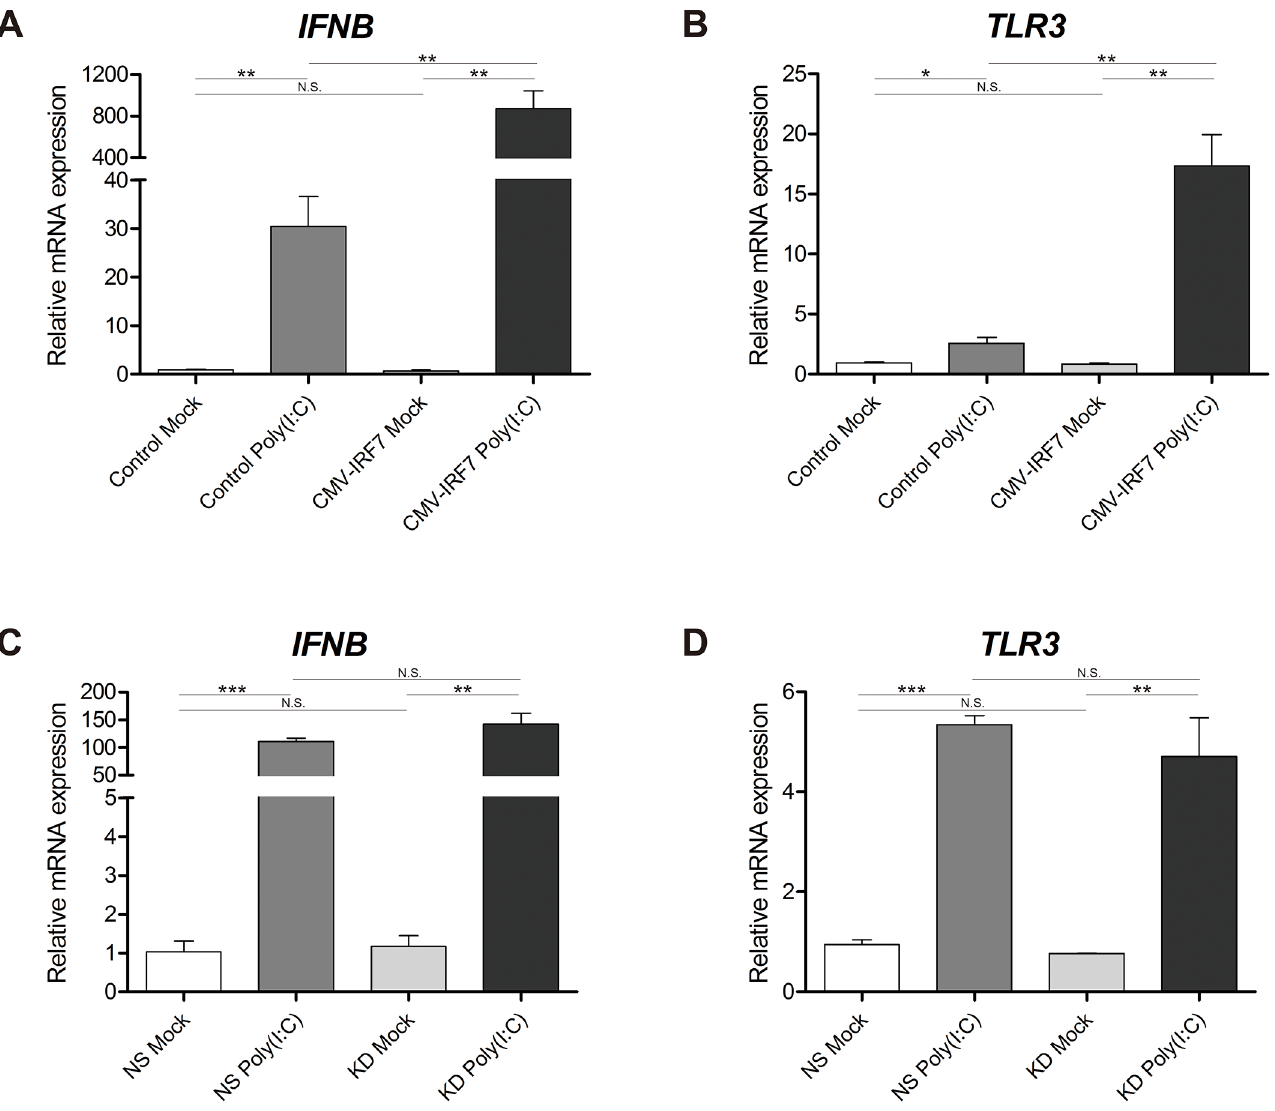
Fig 4. Expression of IFNB and TLR3 in the overexpression and knockdown cell lines. Relative expression levels of IFNB (A, C) and TLR3 (B, D) were confirmed by qRT-PCR in the mock or poly(I:C) induced overexpression or knockdown cell lines and their respective controls. * P < 0.05, ** P < 0.01, *** P < 0.001, N.S.: not significant. Error bars indicate the SEM of triplicate